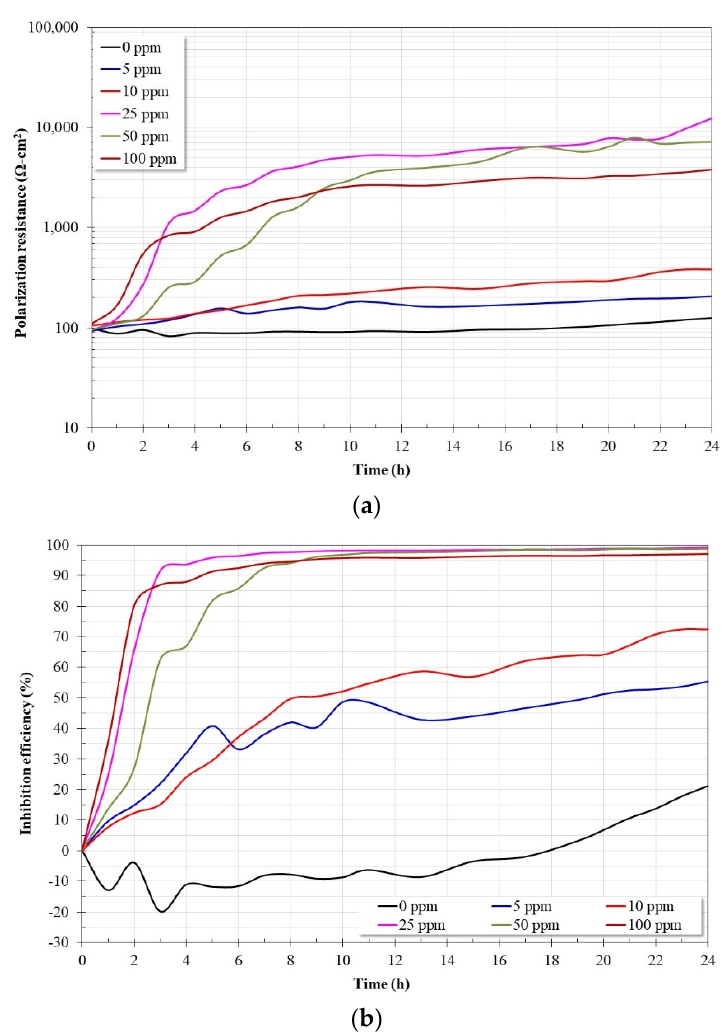
Figure 2. ( a ) Rp variation for API-X52 steel in CO 2 -saturated brine at 60 °C, with and without inhibitor addition. ( b ) Inhibition efficiency as a function of inhibitor concentration.